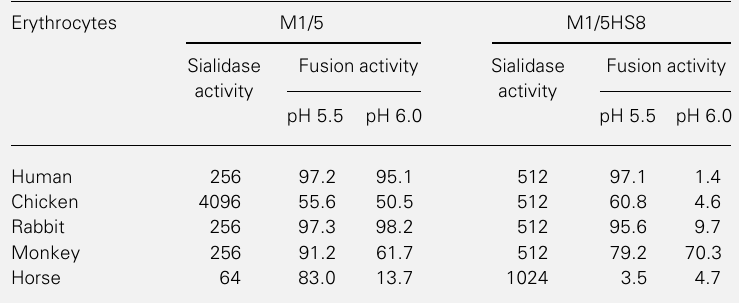
Table 2 - Sialidase and fusion activities of influenza A/Memphis/102/72 (M1/5) virus and a receptor binding variant (M1/5HS8) derived from it. The mutant was obtained from M1/5 by replication in the presence of 1% horse serum, which contains 95% of its sialic acid residues in the N-glycolyl form. Sialidase activity was measured in a neuraminidase-lectin assay and is reported as the reciprocal of the highest virus dilution causing complete hemagglutination by PNA. Fusogenic activity was measured by hemolysis and activity is reported as percent hemolysis measured at 545 nm. All virus strains were previously standardized at 1,024 HAU/25 µl.